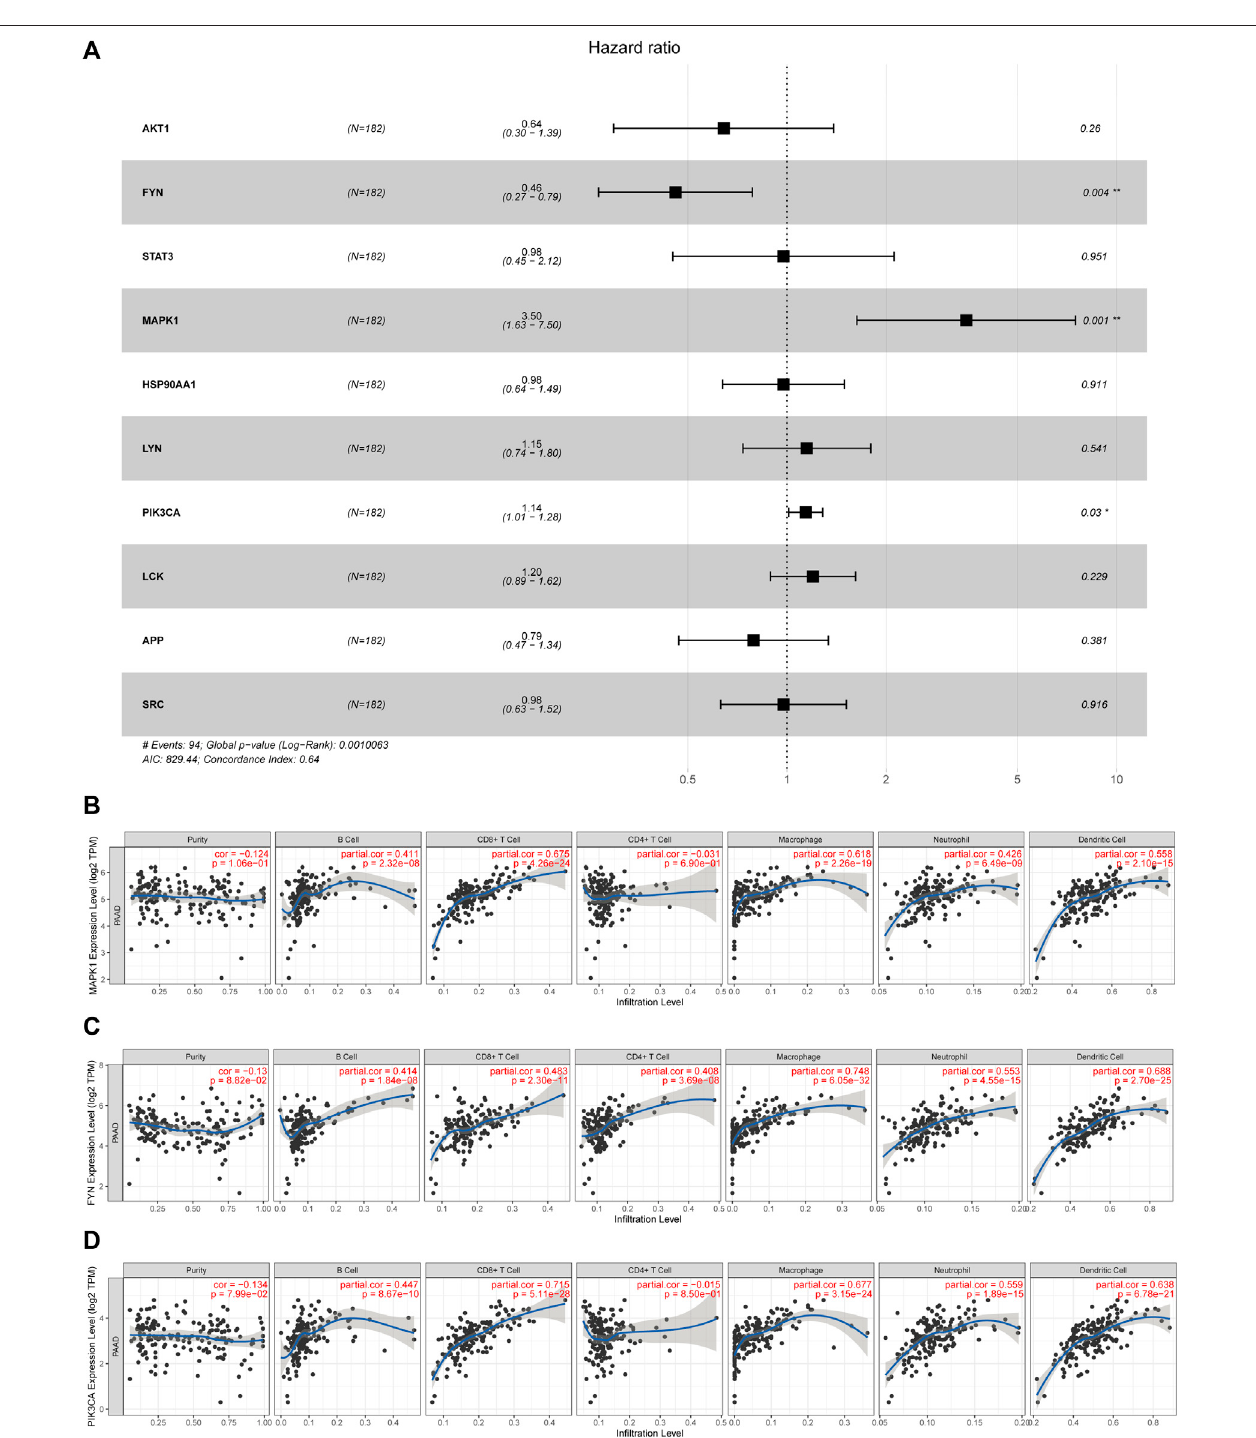
FIGURE5| Identi fi cationofcoretargetswithasigni fi cantprognosticvalueinpancreaticcancer. (A) ForestplotshowedHR(95%CI)and p -valueofcoretargetsby multivariateCoxproportionalhazardsmodel;* p < 0.05and** p < 0.001. (B – D) Correlationsofthetargetexpressionlevelandimmunecellin fi ltration(purity,Bcells,CD8 + cells, CD4 + cells, macrophages, neutrophils, and dendritic cells).